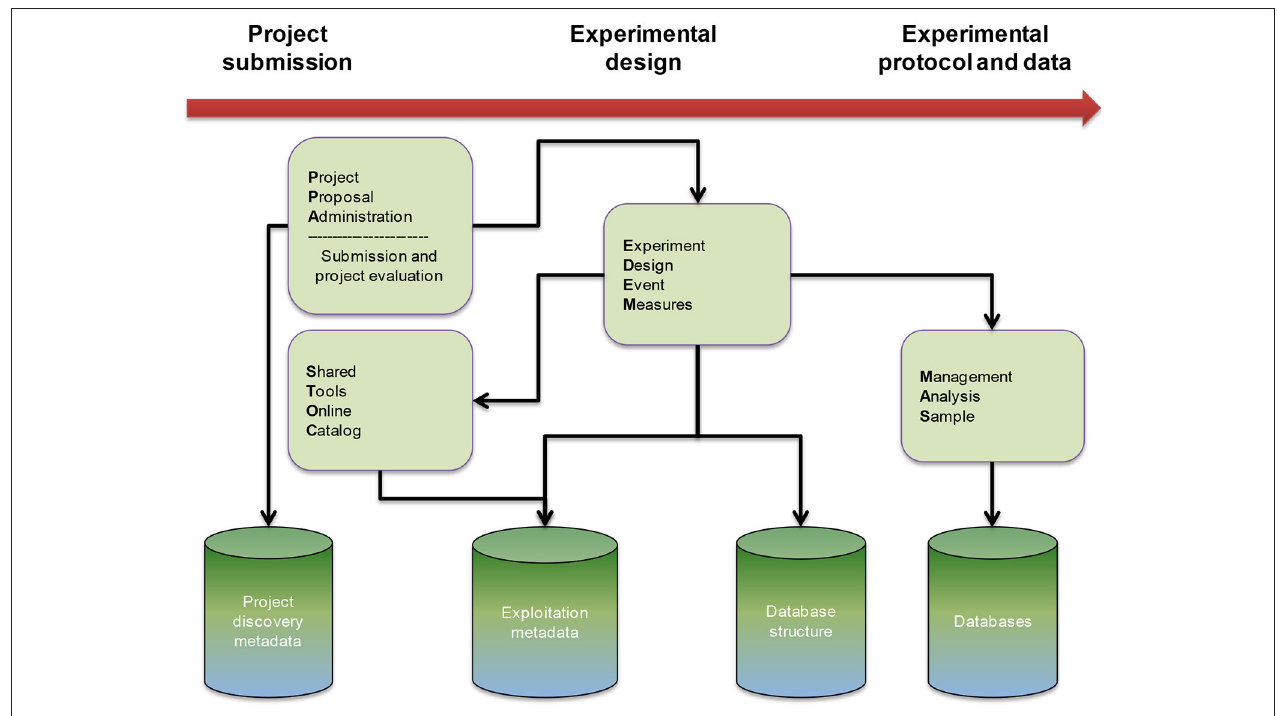
FIGURE 4 | Information system for the administration of AnaEE RI including dedicated web applications for project submission (Project Proposal Administration), project implementation (Experiment Design Event Measures) and data management (Management Analysis Sample). The diagram shows the flow path from project submission to data production and storage, and associated databases dedicated to project and exploitation metadata, database structure and raw